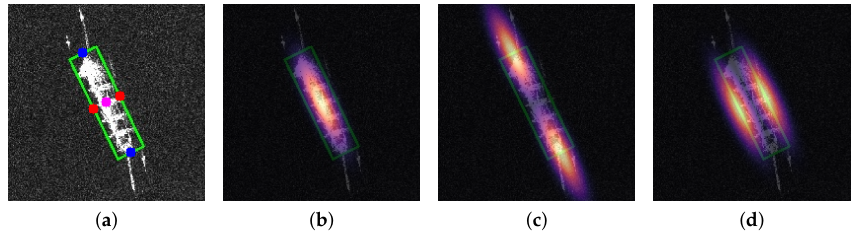
Figure 4. Definition of key points for SAR ship detection. ( a ) Three types of key points. The purple, blue and red dots represent the key points at the TC, SCs and LCs, respectively. The green box is the ground truth of OBB. ( b – d ) are the shape-aware oriented Gaussian training targets for the TC, SC and LC key points,